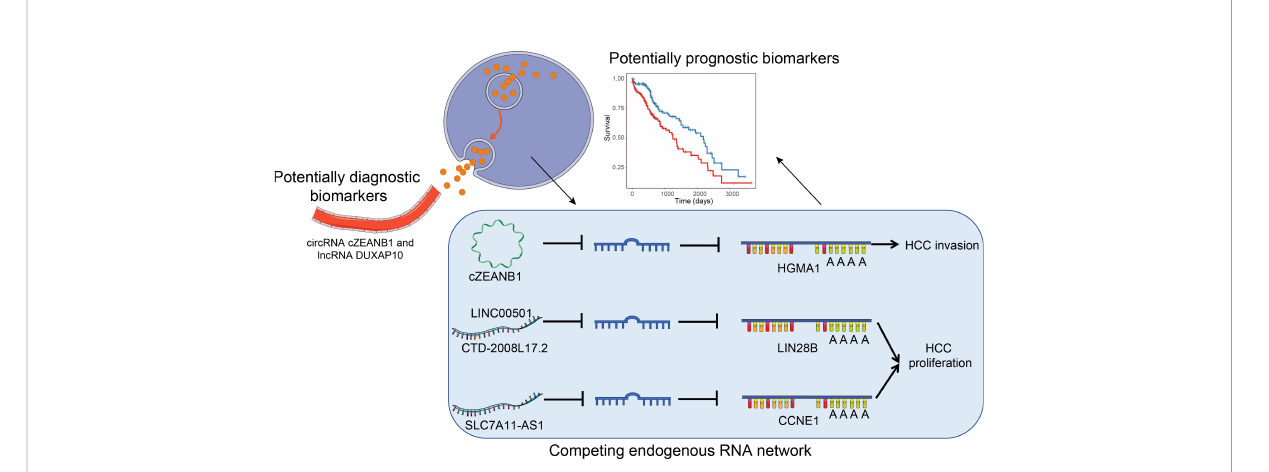
FIGURE 1 The overall major fi ndings of this